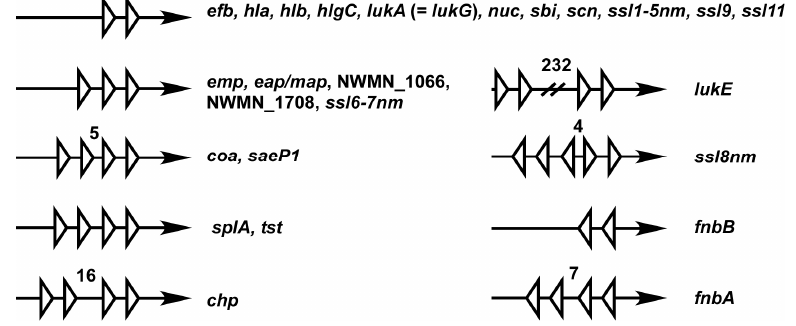
Figure 5. Organization of SBSs in the sae target gene promoters. Each white triangle represents a half of the SaeR binding sequence. Arrows represent promoter region pointing the direction of transcription. Unless stated otherwise, the distance between each half binding sequence is 6 bp. Numbers are base pairs of the gap between the half ‐ binding sites.